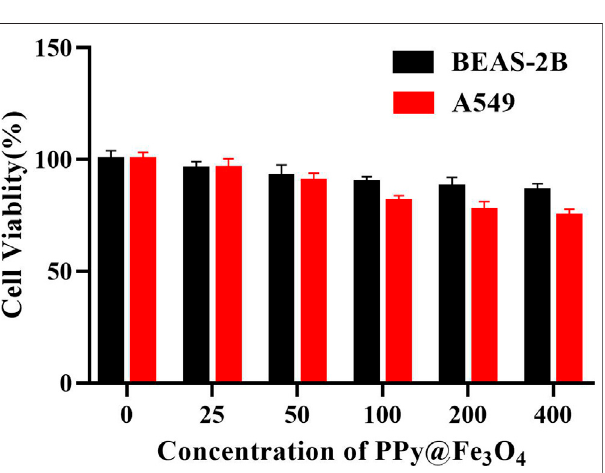
FIGURE 3 | Cell viability of A549 cells and BEAS-2B cells cultured with PPy@Fe 3 O 4 NPs for 24 h at different